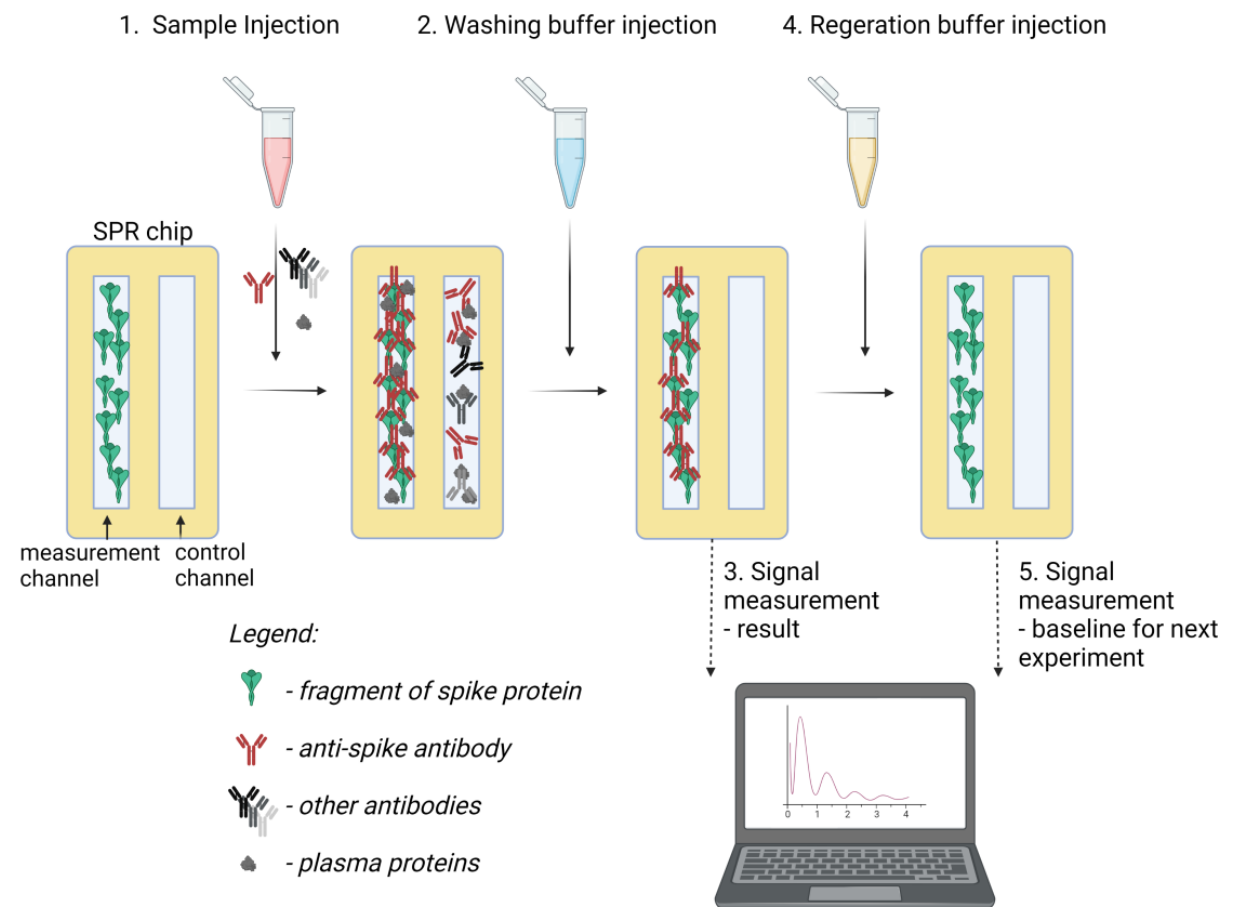
Figure 1. Graphical representation of the used test procedure for plasma sample measurement with SPR chip. Created with BioRender.com.